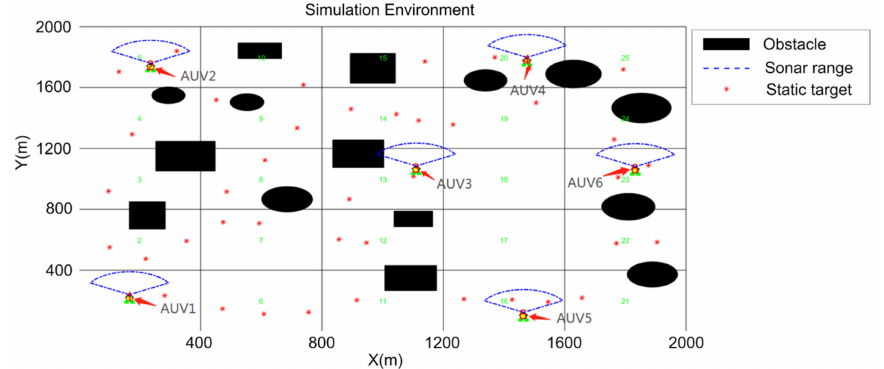
Figure 20. Initialization of simulation environment.